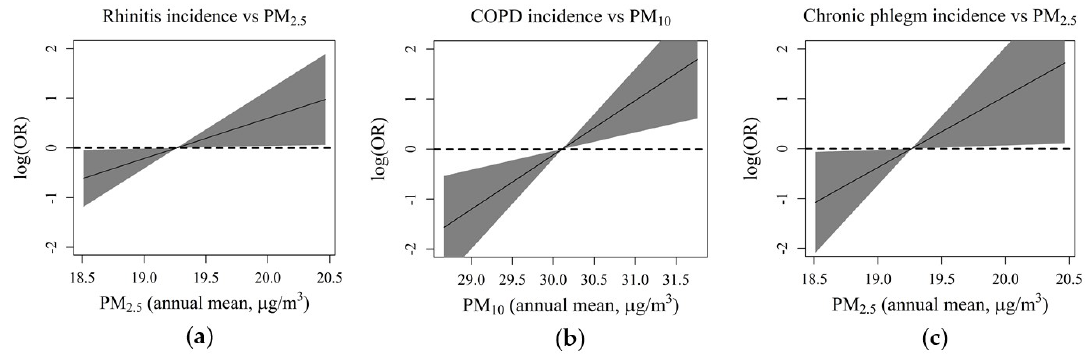
Figure 2. Exposure-response functions: ( a ) PM 2.5 vs. rhinitis incidence; ( b ) PM 10 vs. COPD incidence; ( c ) PM 2.5 vs. of chronic phlegm incidence. The log-ORs were calculated assuming the median annual concentrations of PM as the reference (30.1 µg/m 3 for PM 10 and 19.3 µg/m 3 for PM 2.5 ).